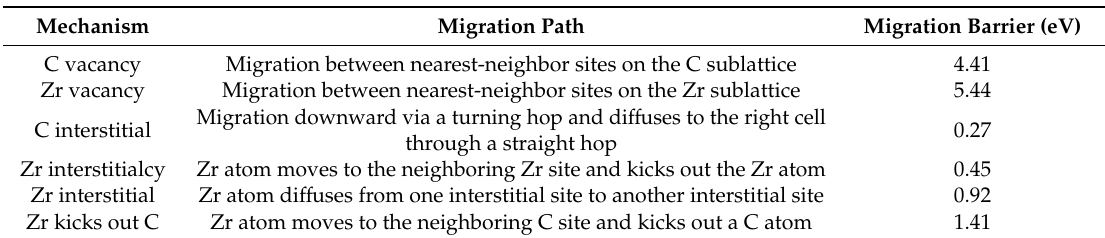
Table 3. Migration barriers of point defects following various di ff usion mechanisms in ZrC